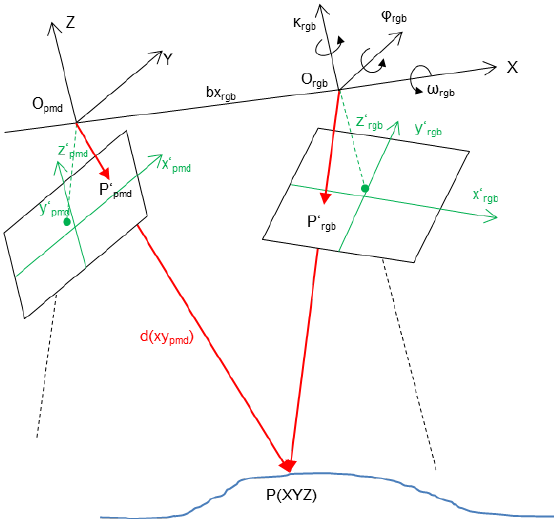
Figure 2. Camera and object coordinate system